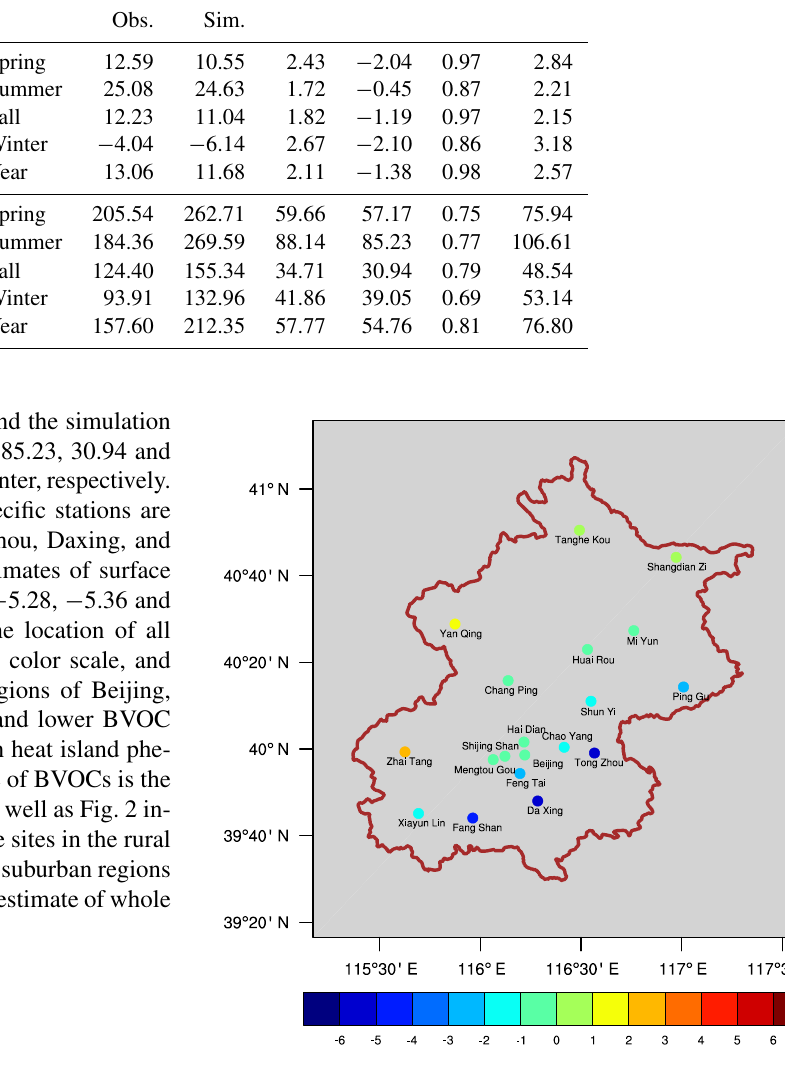
Figure 2. Spatial distribution of the mean bias (MB) of temperature (T2) from all available